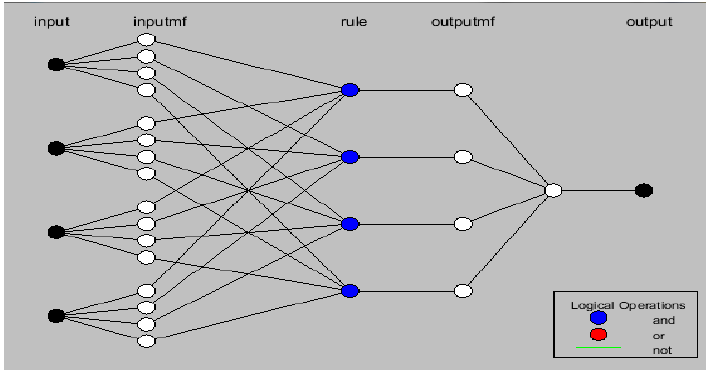
Figure 4. The structure of the proposed ANFIS model.